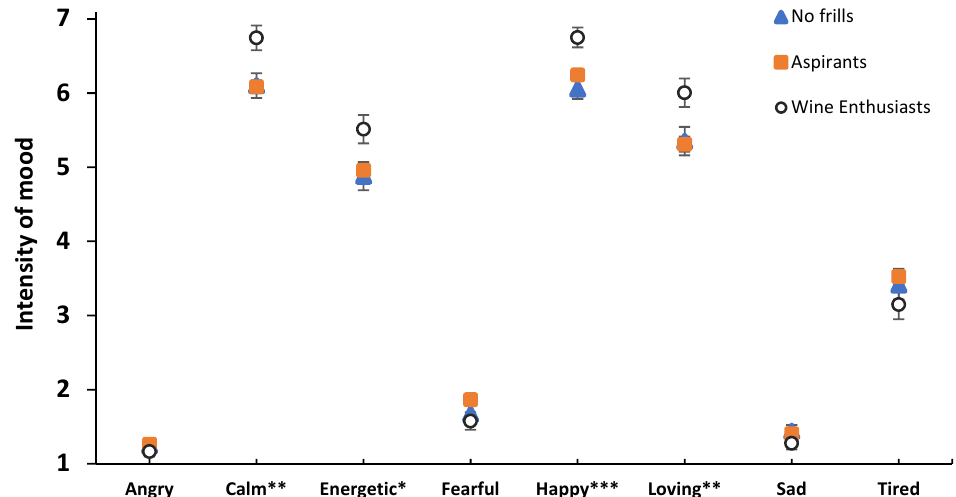
Figure 7. Consumers’ moods by fine wine segments (FWS) prior to tasting the samples. Results pooled for context. Mood intensities were measured on a 9-point scale, ranging from 1 = not at all to 9 = extremely. Error bars indicate standard error. * indicates significant differences between FWS at p < 0.05, ** at p < 0.01 and *** at p < 0.001.